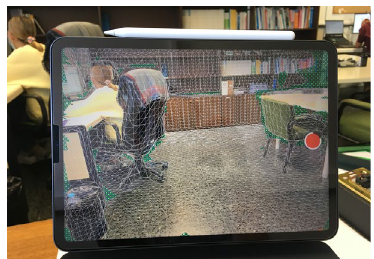
Figure 1: View of the data capture process.